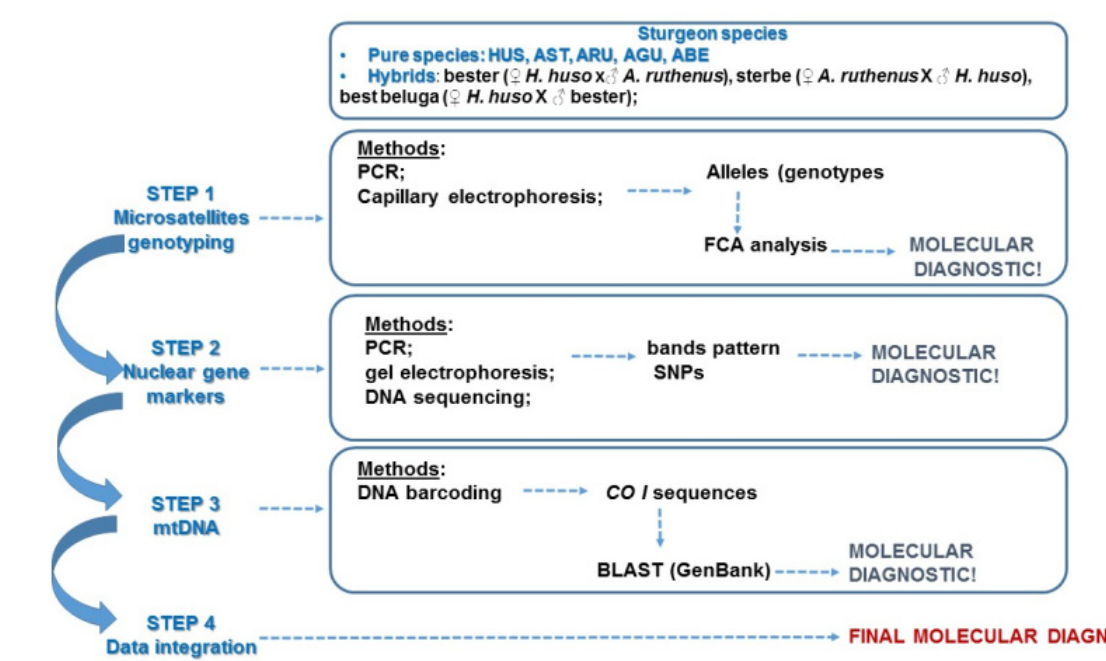
Figure 1. Flow diagram of the experimental procedures used for the set-up of multistep DNA-based method for sturgeon species detection. Table 1. List of sturgeon ( Acipenseridae family) species included in the